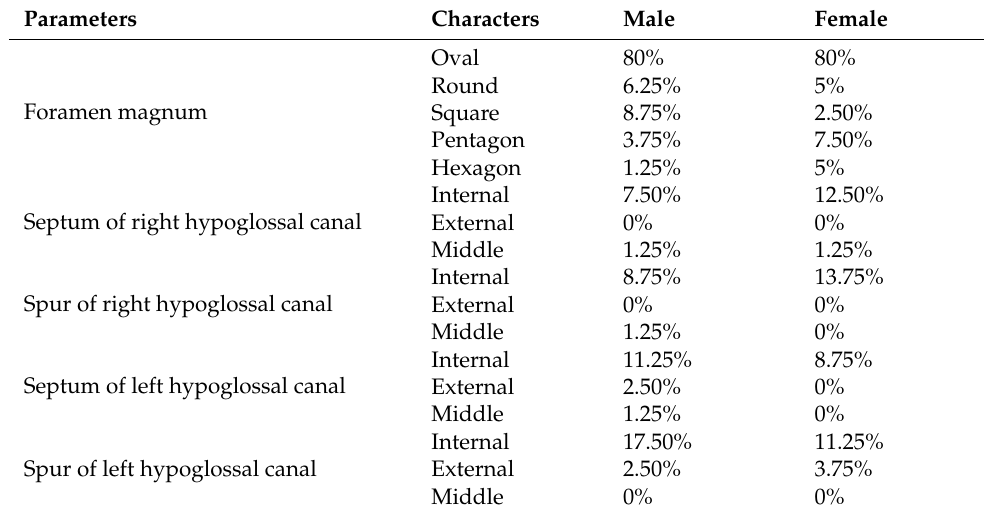
Table 2. Anatomical variation in the foramen magnum and hypoglossal canal.